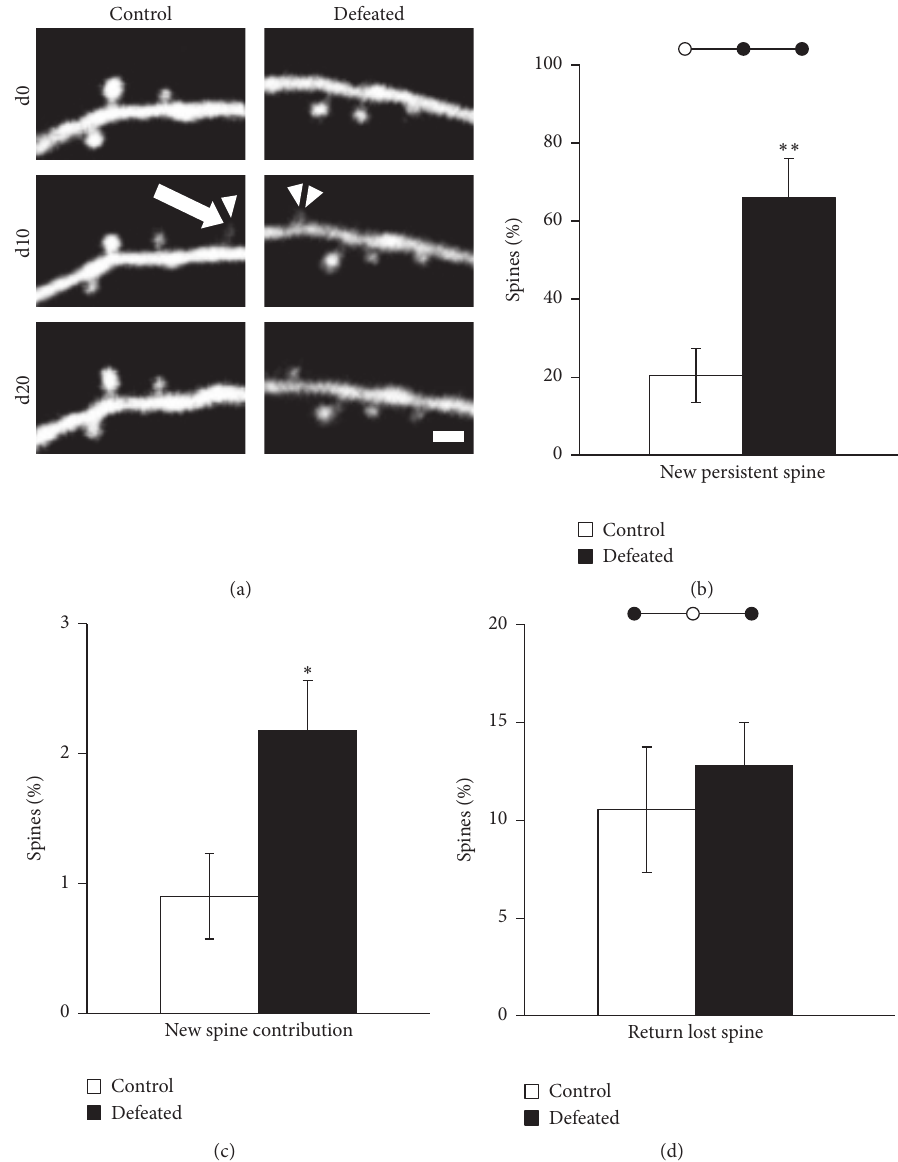
Figure 3: Enhanced persistence of newly formed spines in defeated mice. (a) Examples of a newly formed spine of a control (left) and a defeated (right) mouse with different fate. The defeated mouse experienced CSDS during day 0–day 10 and then recovery period during day 10–day 20. Arrowhead and arrow indicate the unstable newly formed spine which formed and then disappeared. Double arrowhead indicates the stable newly formed spine which formed and then stayed. Scale bars = 2 𝜇 m. (b) Percentage of new persistent spines at day 20 in control ( 𝑛 = 9 ) and defeated ( 𝑛 = 10 ) mice [Student’s 𝑡 -test: ∗∗ 𝑃 < 0.01 ]. (c) Ratio of persistent new spines which formed during day 0–day 10 at day 20 in control ( 𝑛 = 9 ) and defeated ( 𝑛 = 10 ) mice [Student’s 𝑡 -test: ∗ 𝑃 < 0.05 ]. (d) Ratio of spines lost in day 0–day 10 and then returned at day 20 in control ( 𝑛 = 9 ) and defeated ( 𝑛 = 12 )